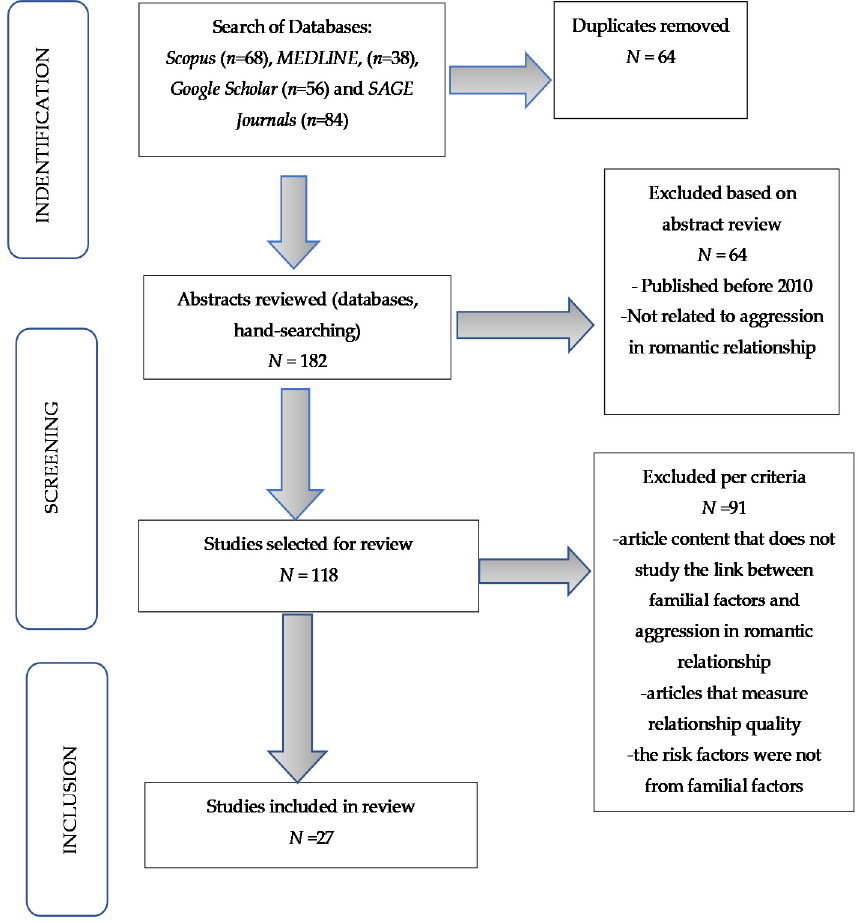
Figure 1. Flowchart of article identification, screening, and inclusion.